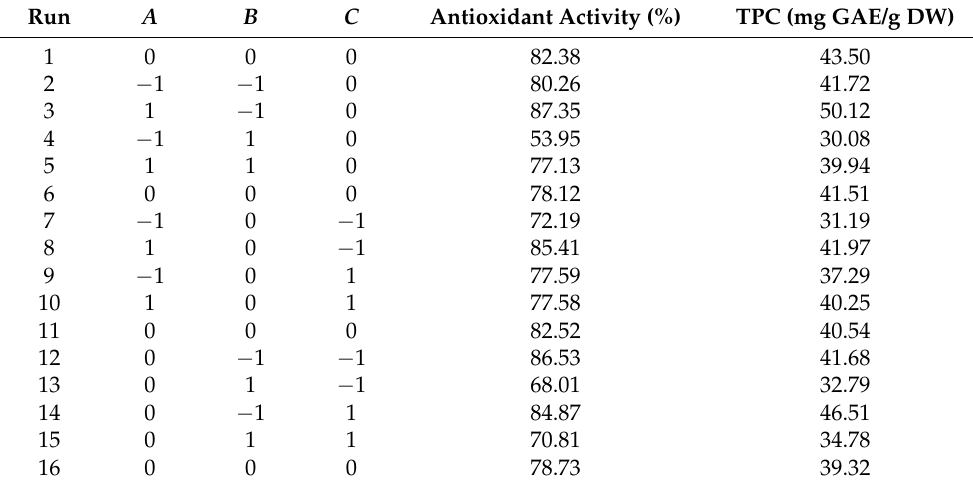
Table 2. Box–Behnken design for three factors of ultrasound-assisted extraction with their observed